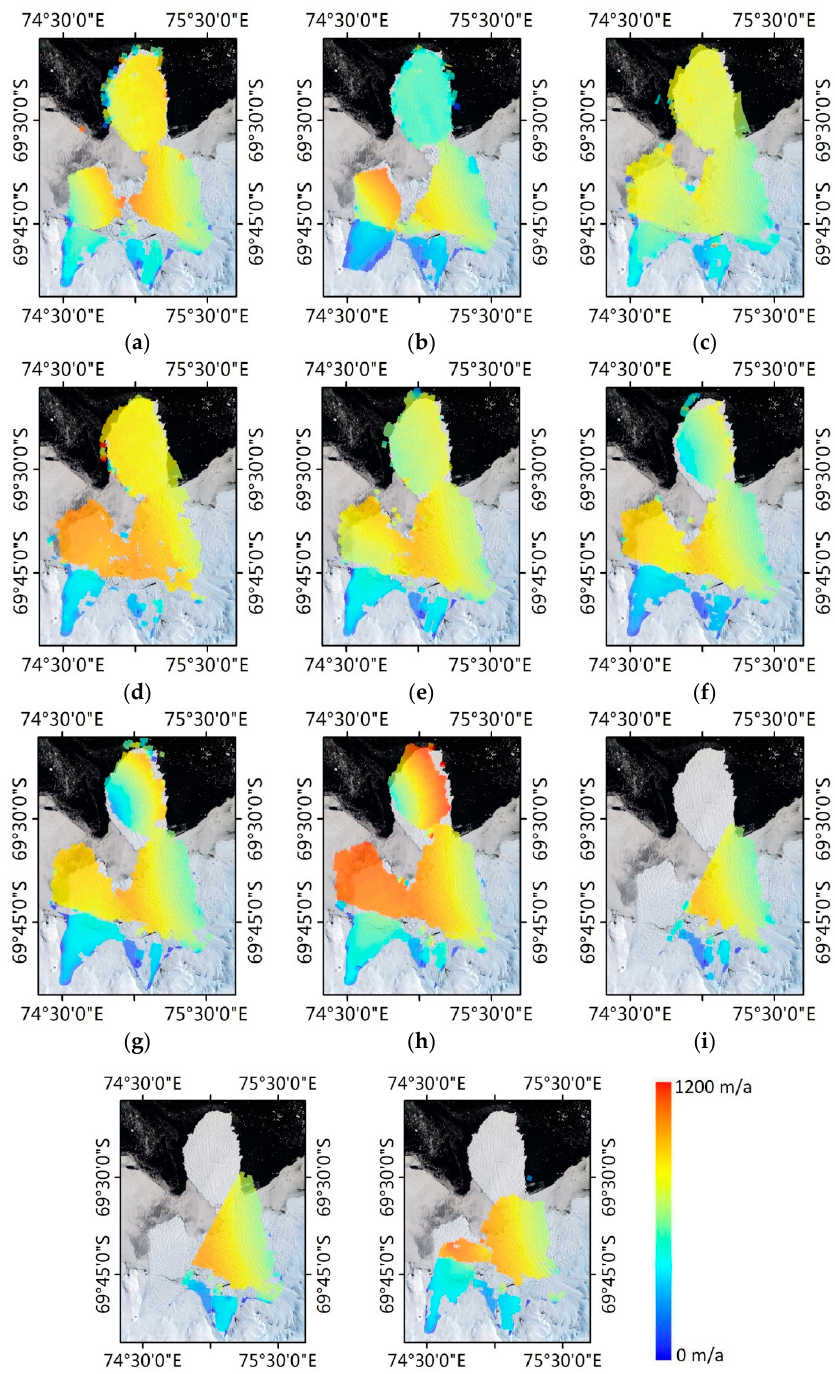
Figure 9. Ice velocity maps for the PRG from 2004 to 2015. The colored areas indicate the ice velocities, from 0 to 1200 m/a. Each ice velocity map uses the same base map. ( a ) 2004 (February 2004 to February 2005, 391 days); ( b ) 2005 (February 2005 to February 2006, 361 days); ( c ) 2007 (November 2006 to